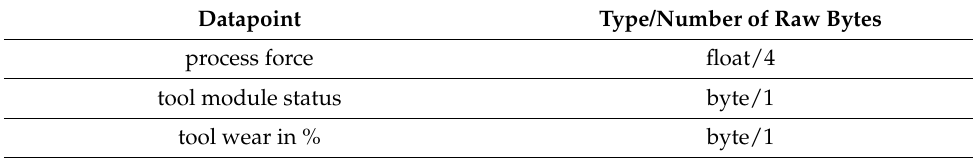
Table 4. Data from the gateway module to the controller.